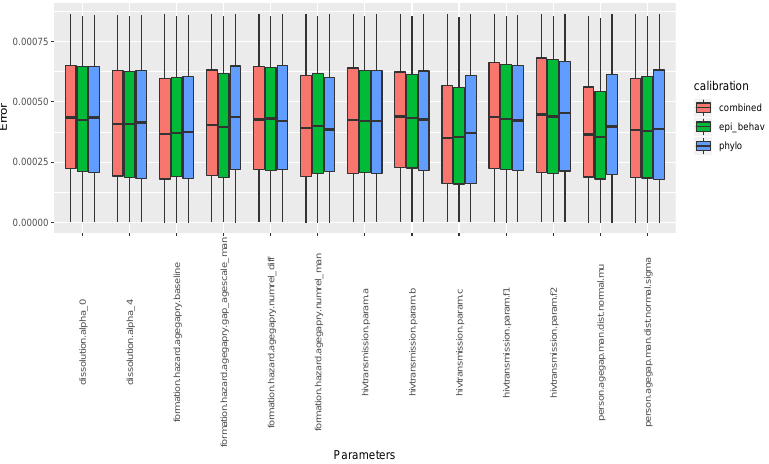
Table A4, all our calibration scenarios performed well in terms of guessing the best fit parameter values.